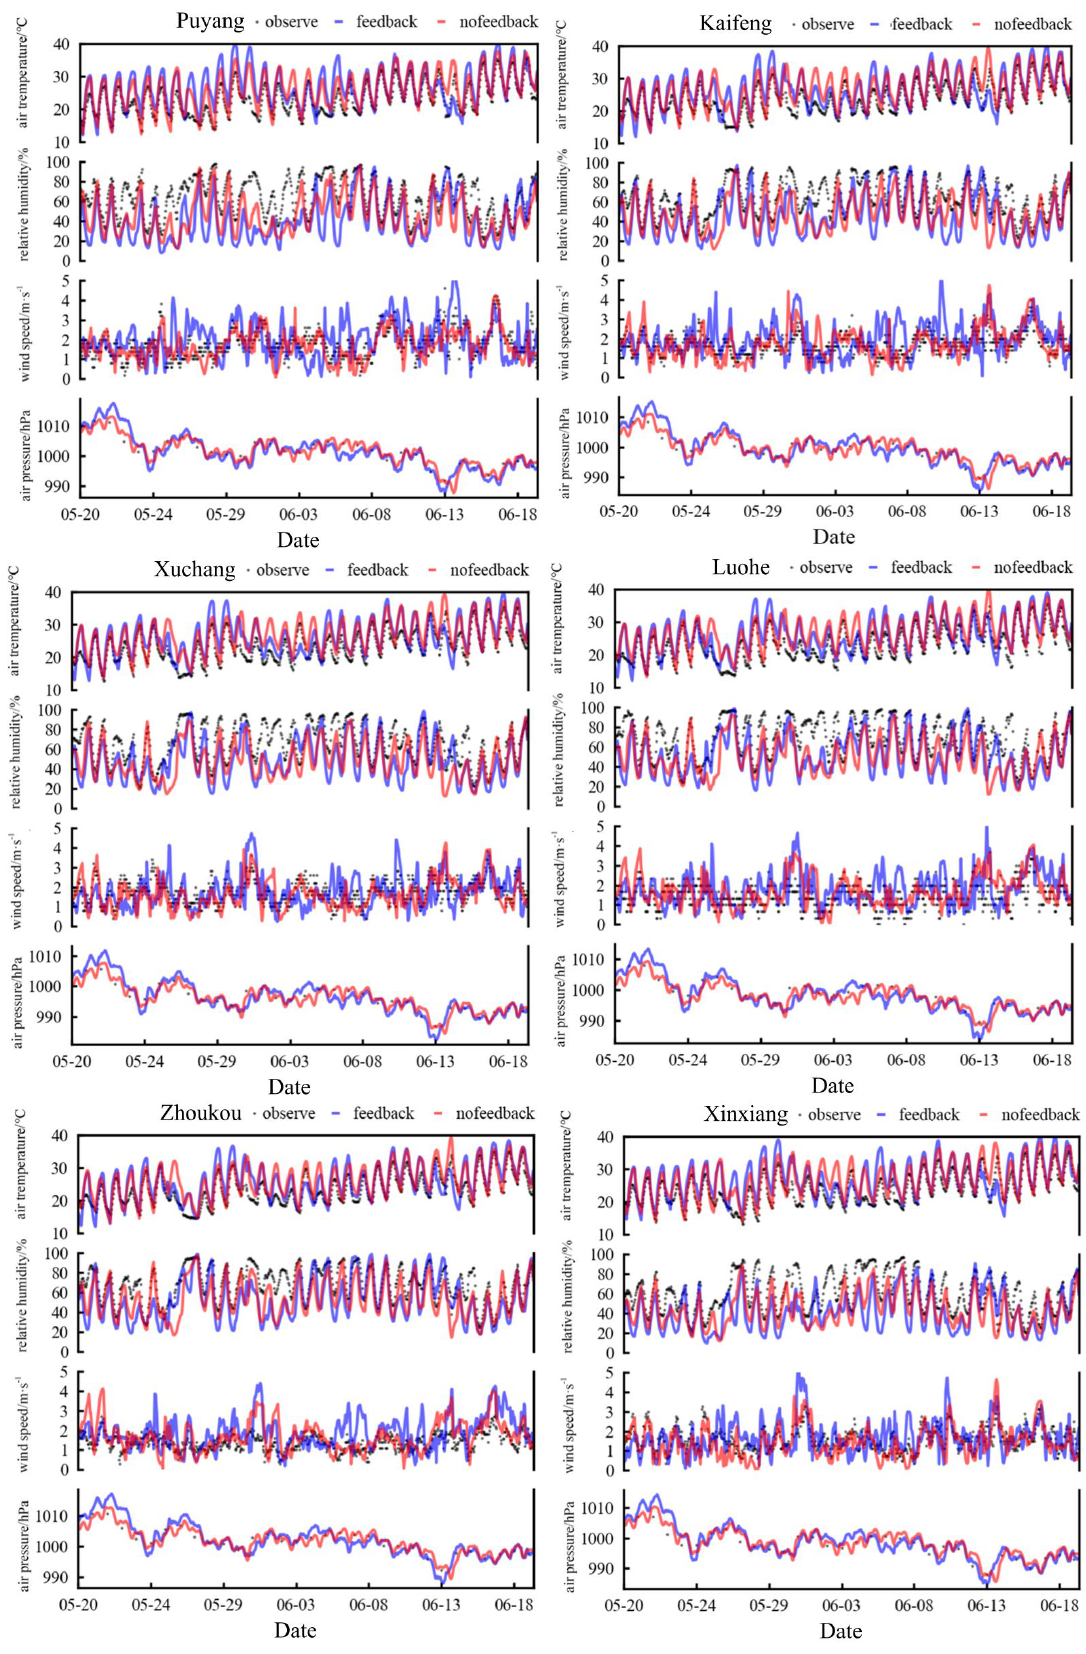
Figure 3. Comparisons of observations and model simulations without (blue line) and with (red line) aerosol feedback.